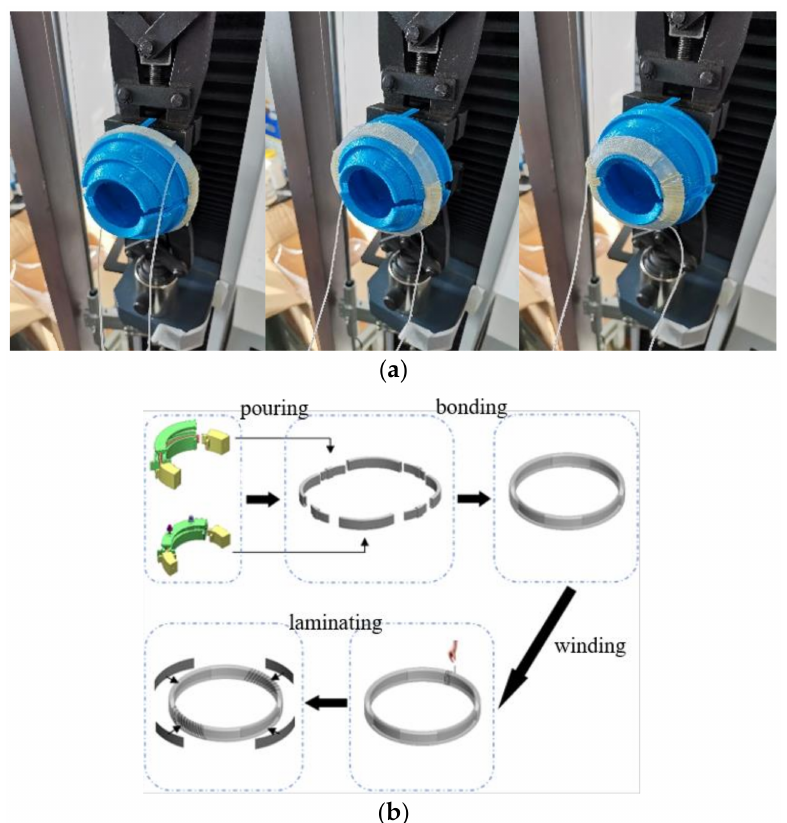
Figure 3. Mechanical performance test experiment of the fiber-constrained annular flexible ac- tuator. ( a ) Three actuators support situations; ( b ) fiber-constrained annular flexible actuator fabrication